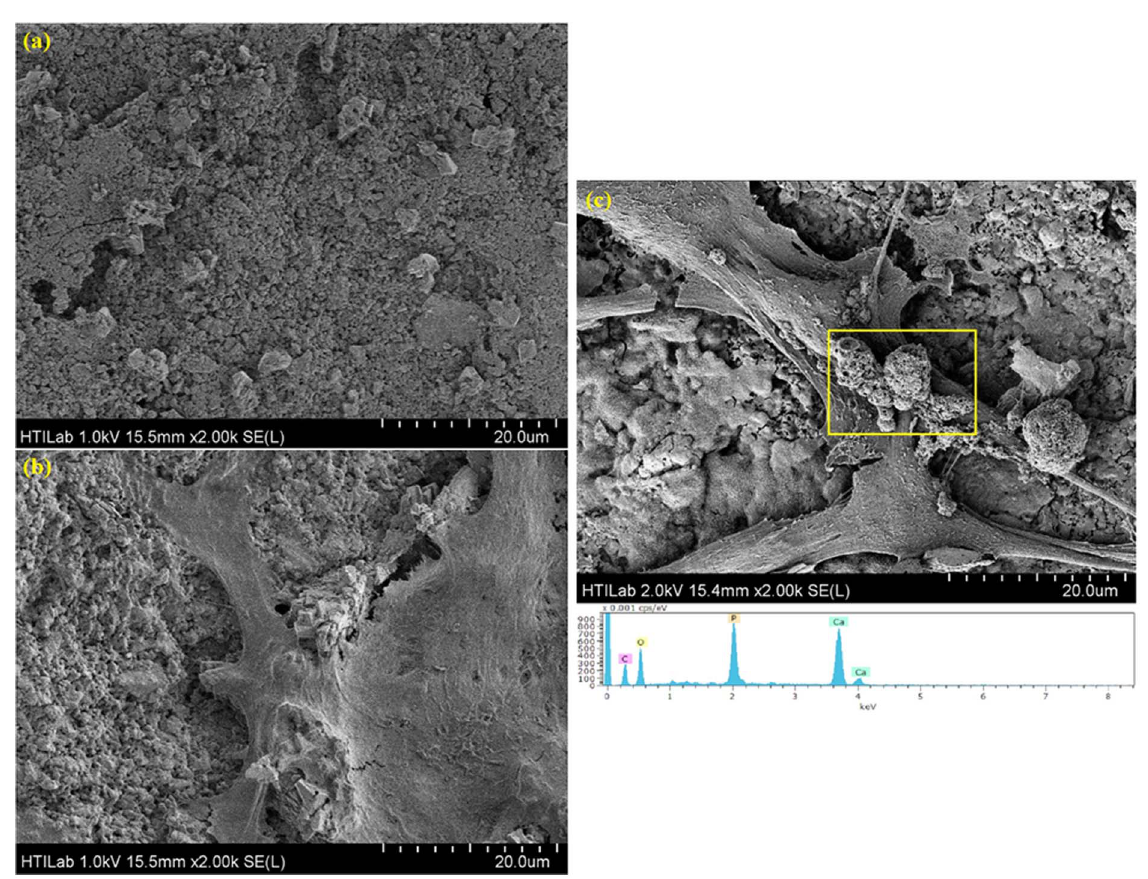
Figure 12. FESEM micrographs and the EDS spectrum of the hFOB cells. (a) 1 wt.%GNP/CS composite without cells, (b) Pure CS with hFOB cells,(c) FESEM micrographs and the EDS spectrum of the hFOB cells, indicating a significant presence of P and CS on the 1 wt.%GNP/CS composite following 3 days of seeding.